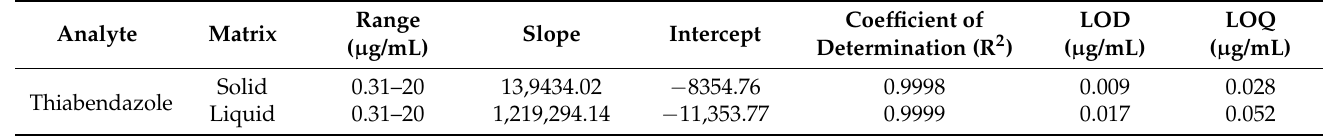
Table 4. Precision and accuracy of the analytical method for thiabendazole in the solid and liquid food samples.